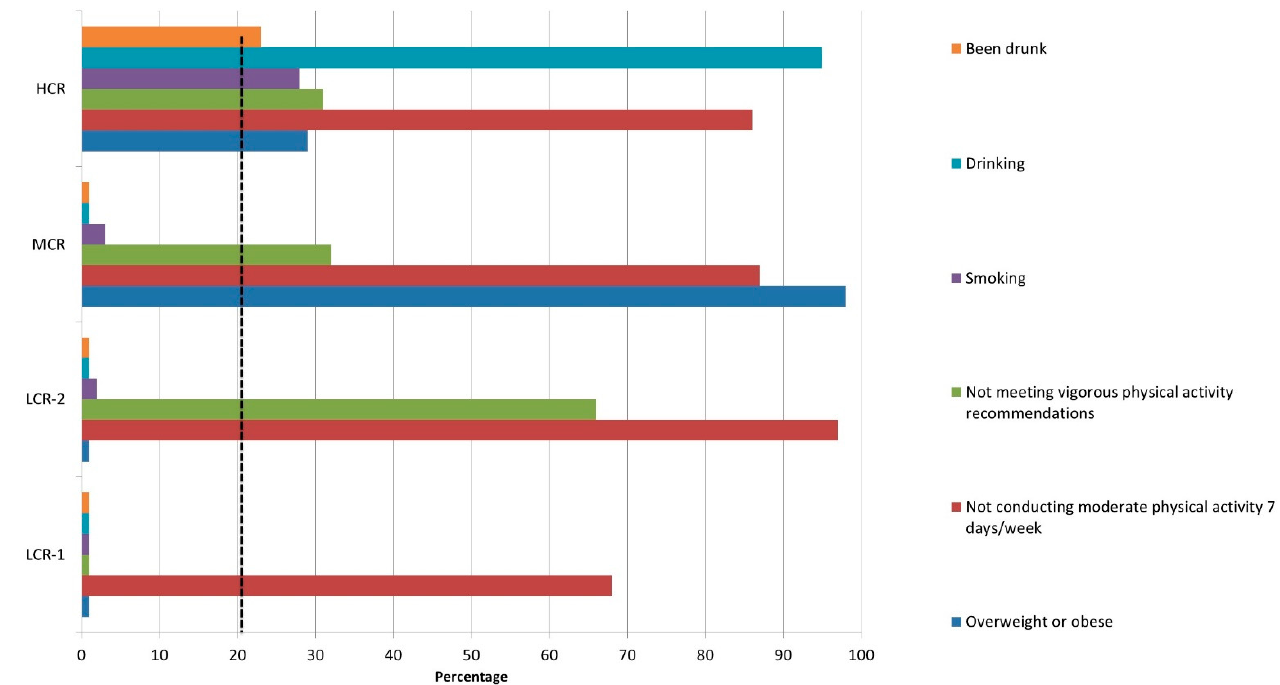
Figure 1. Within-cluster percentage of favorable lifestyle behavior. Abbreviations: HCR, high cardiovascular risk; LCR-1, low cardiovascular risk—group 1; LCR-2, low cardiovascular risk— group 2; MCR, moderate cardiovascular risk. Notes: The vertical dashed black line represents the cut-off for favorable lifestyle (<20% of the sample presented unfavorable lifestyle behavior); The dotted line represents the cut-off for favorable lifestyle behavior, meaning <20% of the sample presenting unfavorable lifestyle behaviors.